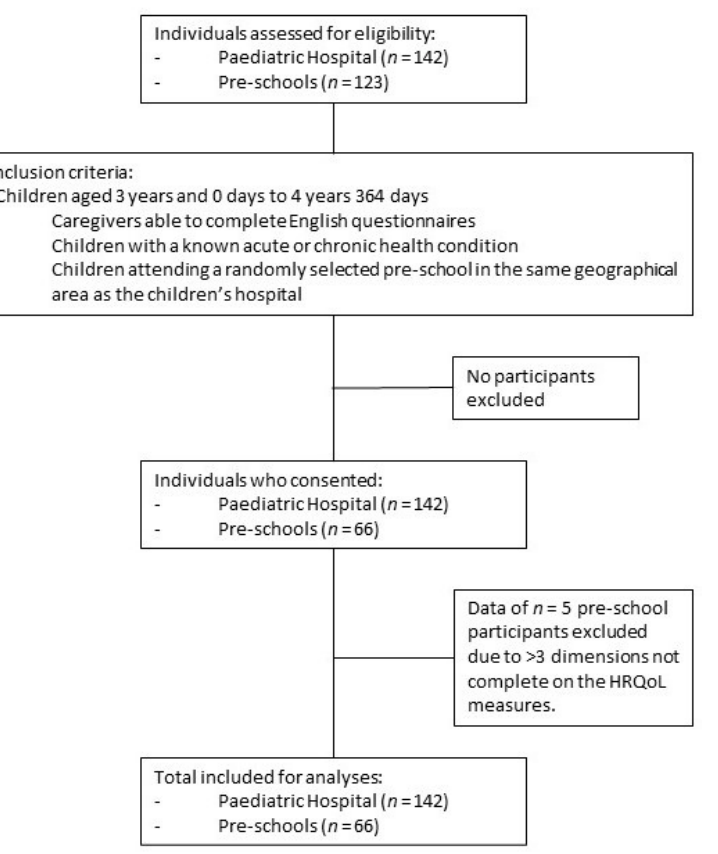
Figure 1. Flow diagram outlining participant inclusion process. The sample size was calculated to identify a difference in proportions of problems reported on the TANDI dimension scores, with a small effect size (0.4), between those with and without a health condition. A sample of 60 children was required in each group ensuring 90% power and a significance of